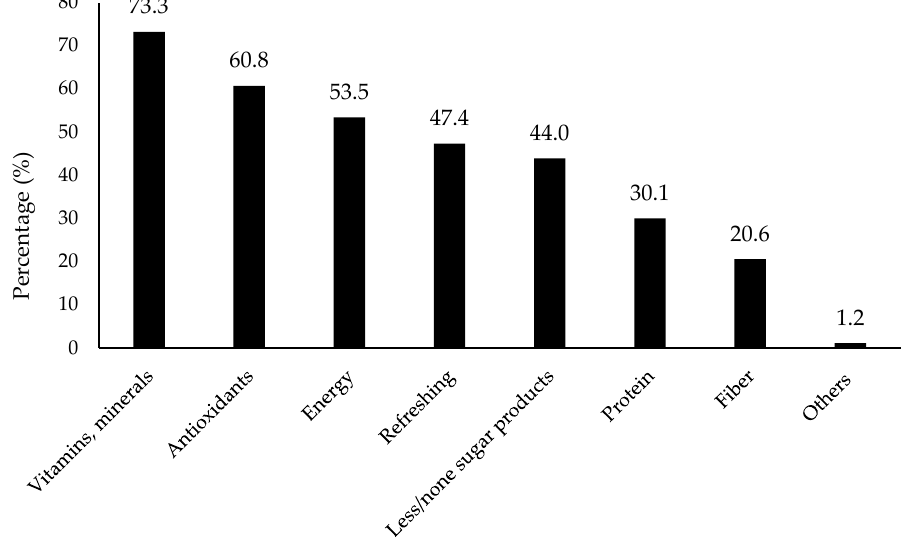
Figure 3. Percentage (%) for extra benefits that consumers expected to be added ( n = 901). Others included grapefruits, strawberry, orange, passion fruit, acai, coconut, herb, pomegranate, cucumber, vanilla, and ginger according to the collected data.